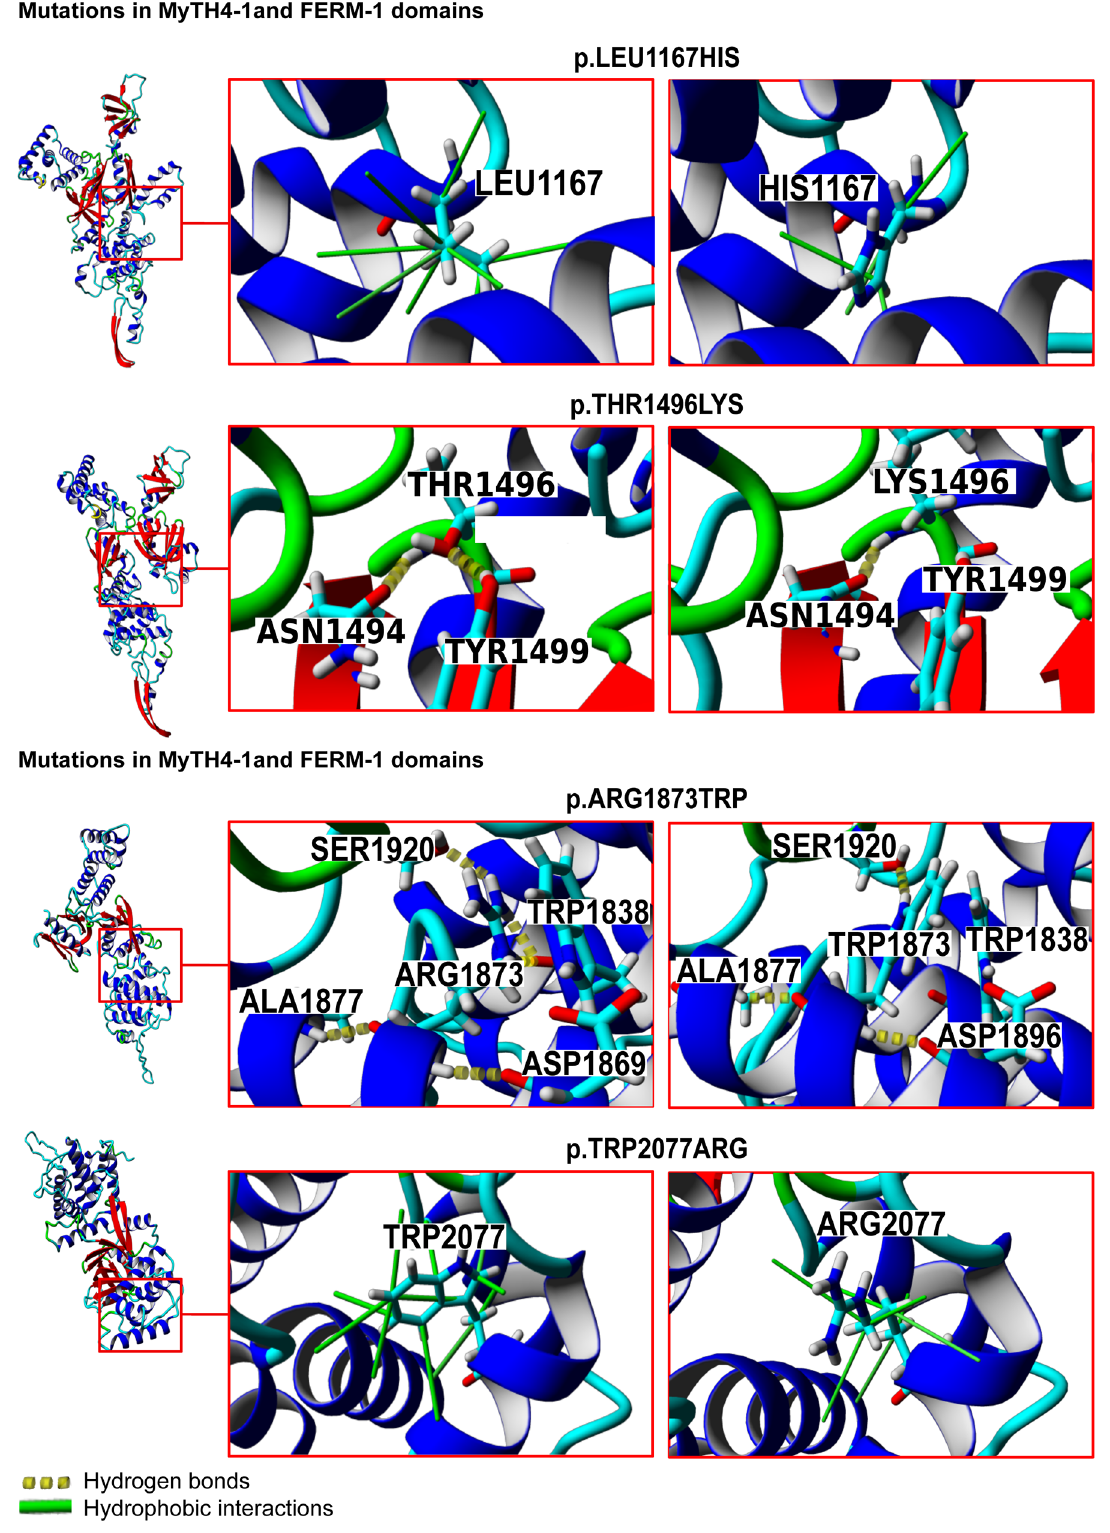
Fig 3. Structural and functional impacts of MYO7A missense mutations, as predicted by molecular modelling and amino acid conservation analysis. Hydrogenbonds and hydrophobic interactions predictedby the Yasara software. Yellow dotted lines represent hydrogenbonds, and green lines represent